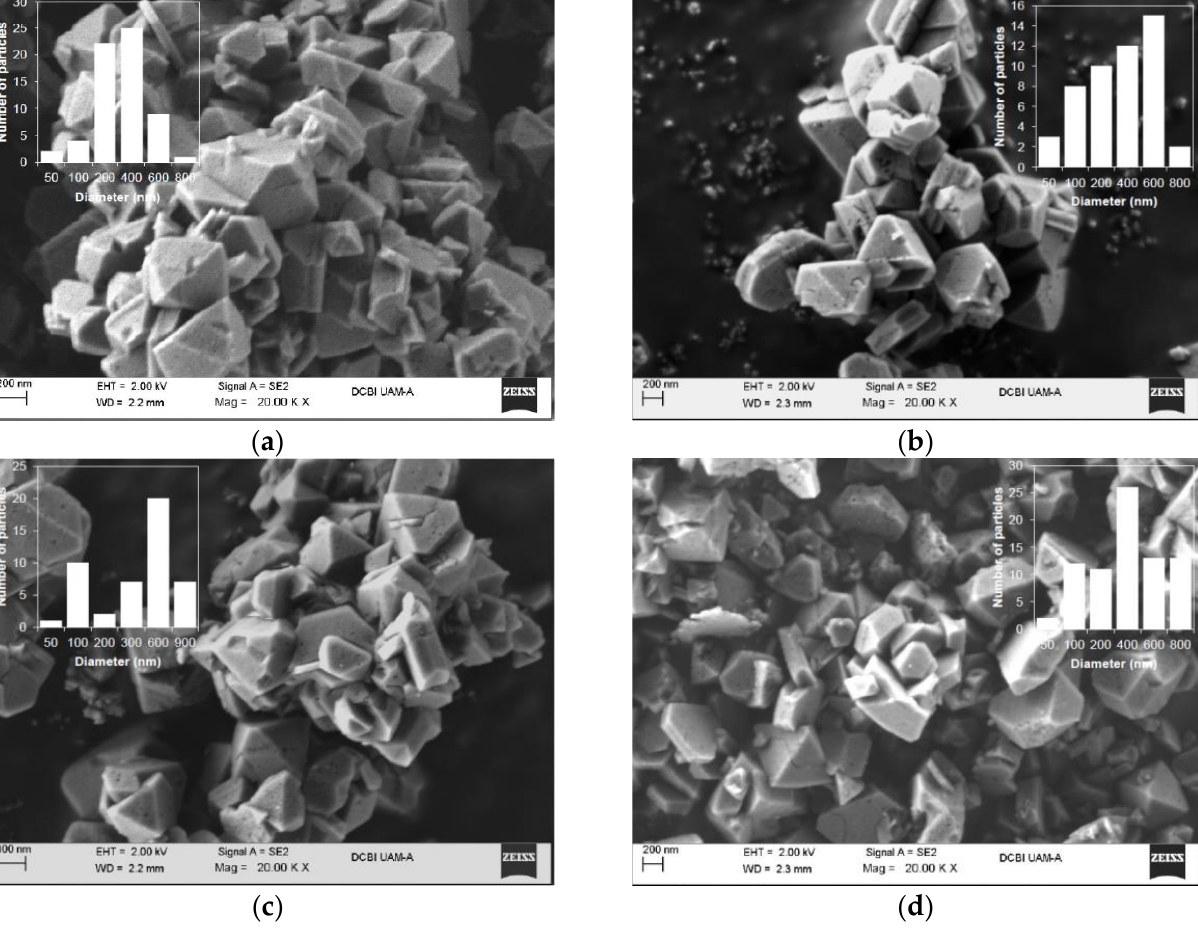
Figure 15. Scanning electron micrographs and particle size distributions of the spent zeolites: ( a ) SZY7, ( b ) SZY17, ( c ) SZY34, and ( d ) SZY45.